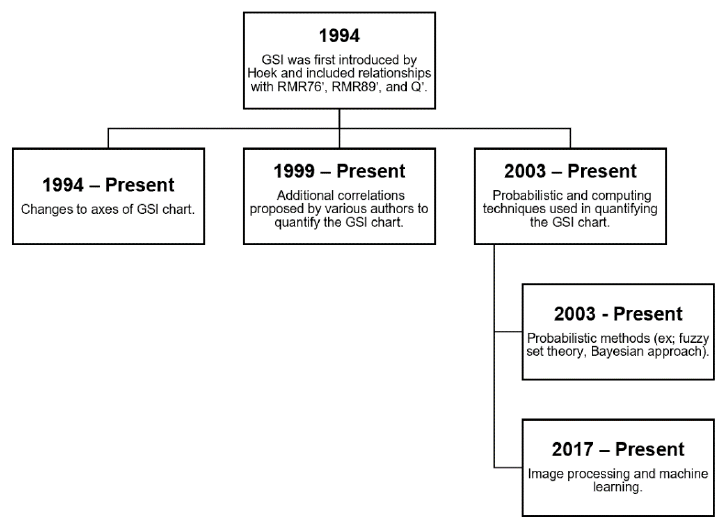
Figure 1. Evolution of GSI and its quantification.